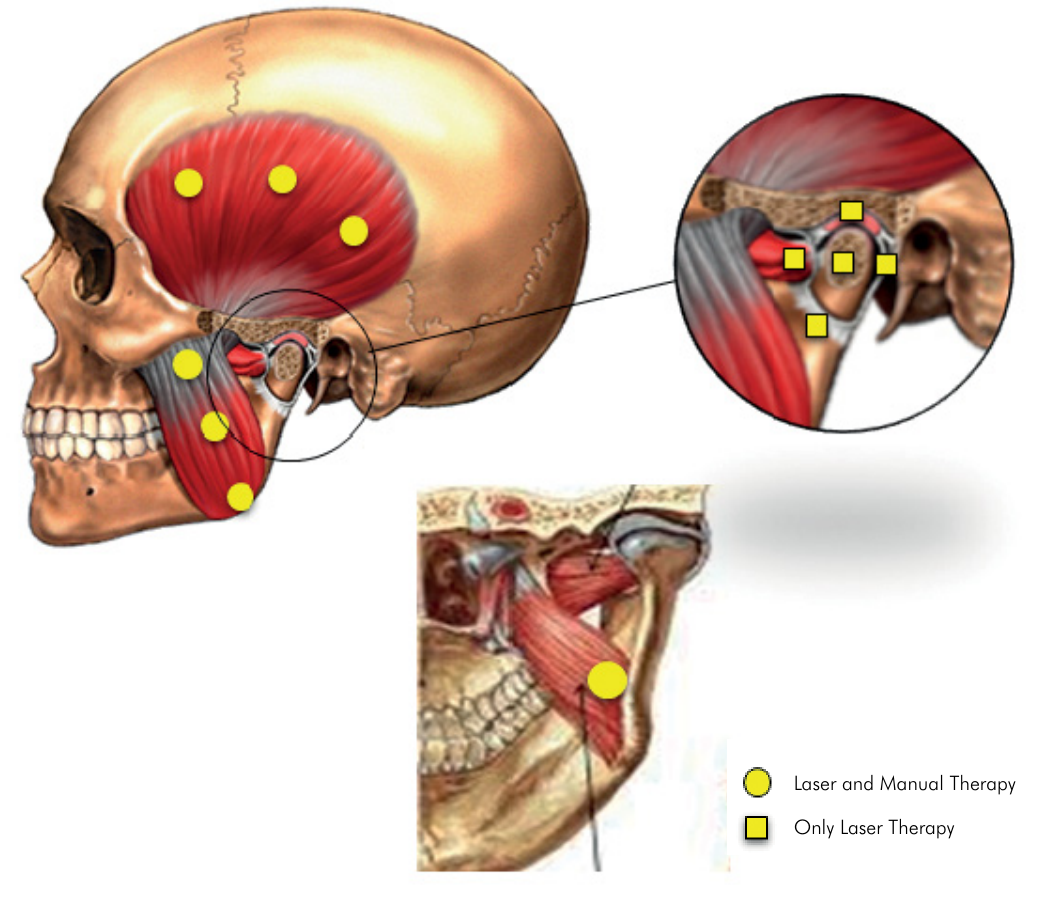
Figure 2. Schematic representation of the points of laser and manual therapy